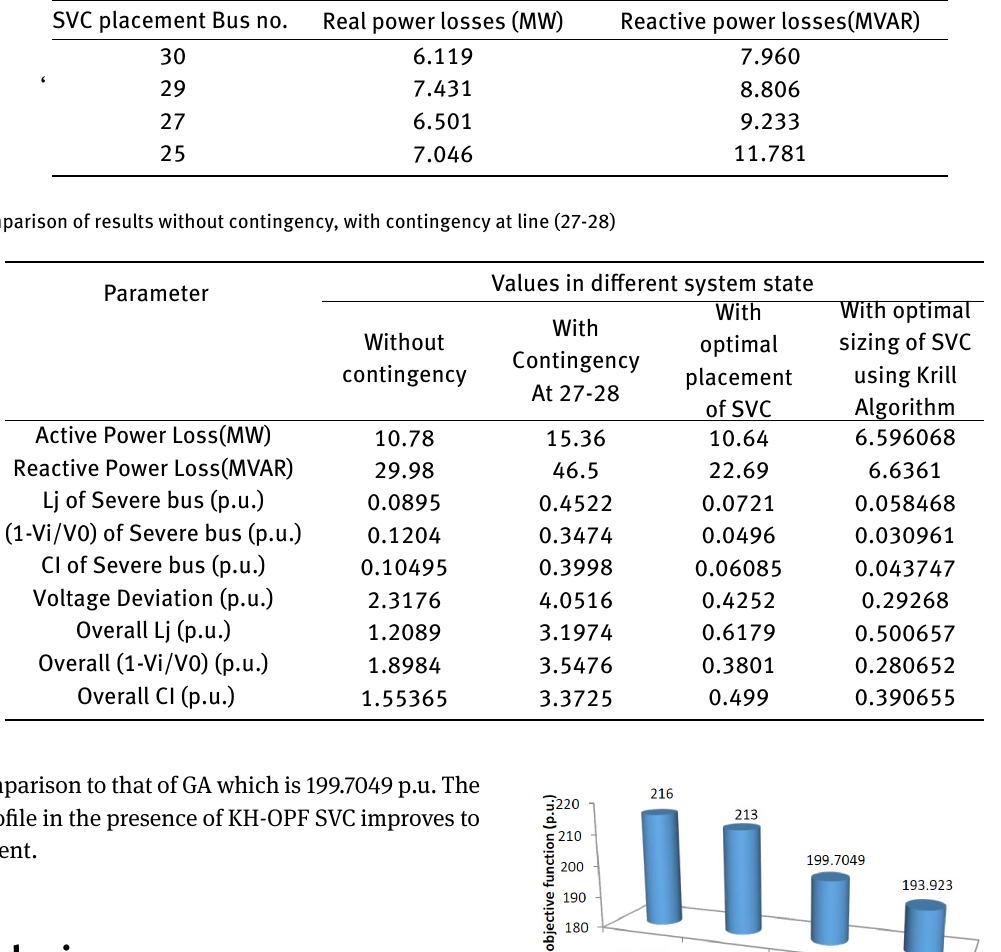
Table 6: Comparison of real and reactive power losses with placement of SVC in different locations under 36th line (27-28) Contingency SVC placement Bus no. Real power losses (MW)